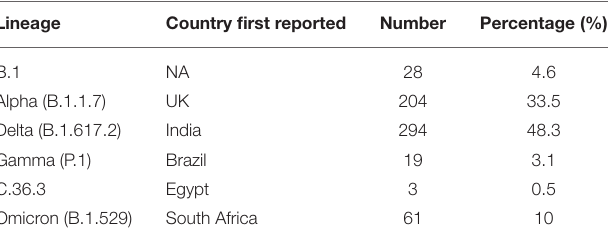
TABLE 1 | Frequency of VOCs identified in Calabria Region from March 2021 to January